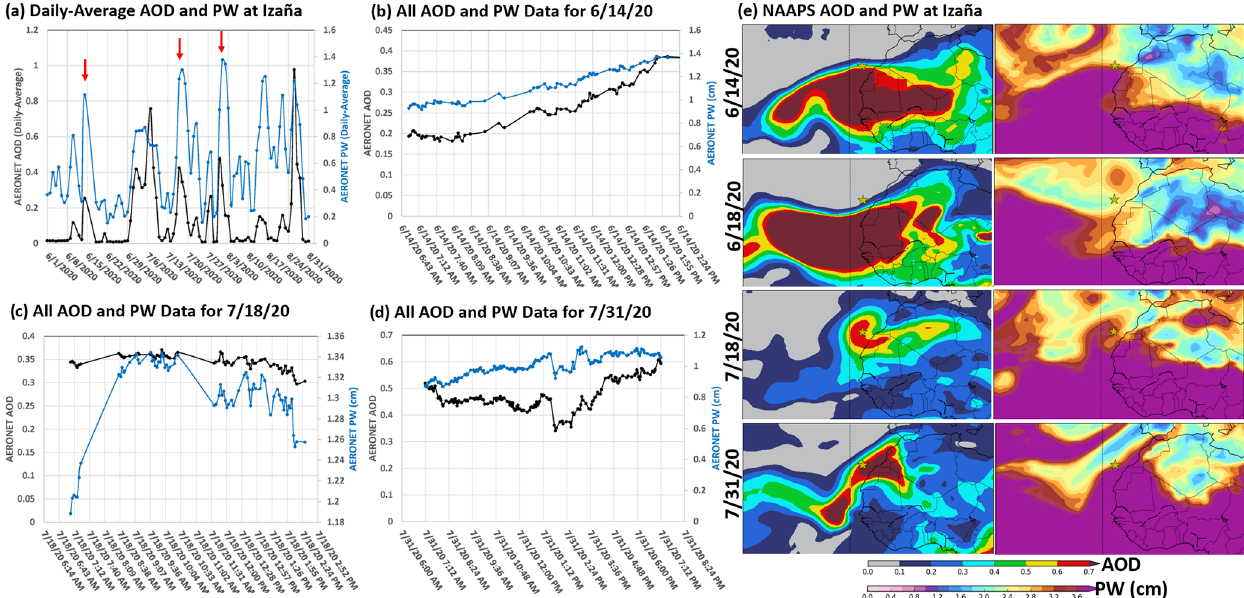
Figure 17. AOD and PW time series at the Izaña site, Canary Islands, in which strong positive correlations are observed during the JJA season. The daily-average AOD and PW time series are shown for the 2020 JJA season, with red arrows indicating select events for which joint peaks in AOD and PW are observed (a) . Time series of AERONET data (non-averaged, all data) for dates identified with red arrows are shown in time series (b–d) . Additionally, NAAPS-RA AOD and PW (cm) fields are shown for the same dates, with the AERONET site marked with a yellow star (e) . The fields for 18 June 2020 are also included which show the joint dip in AOD and PW in the (a) time series after the 14 June